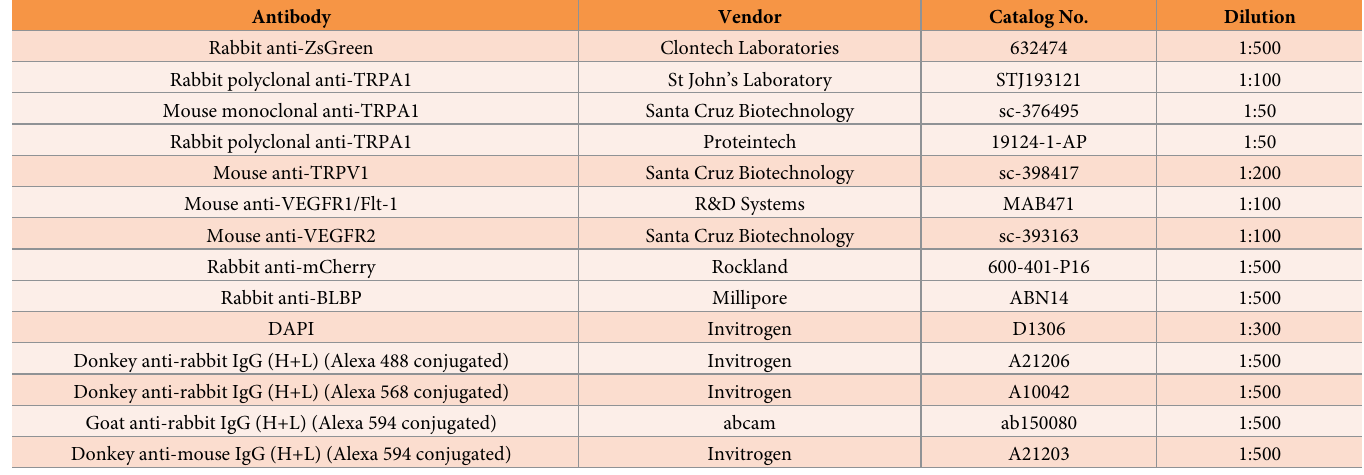
Table 2. Primary and secondary antibodies